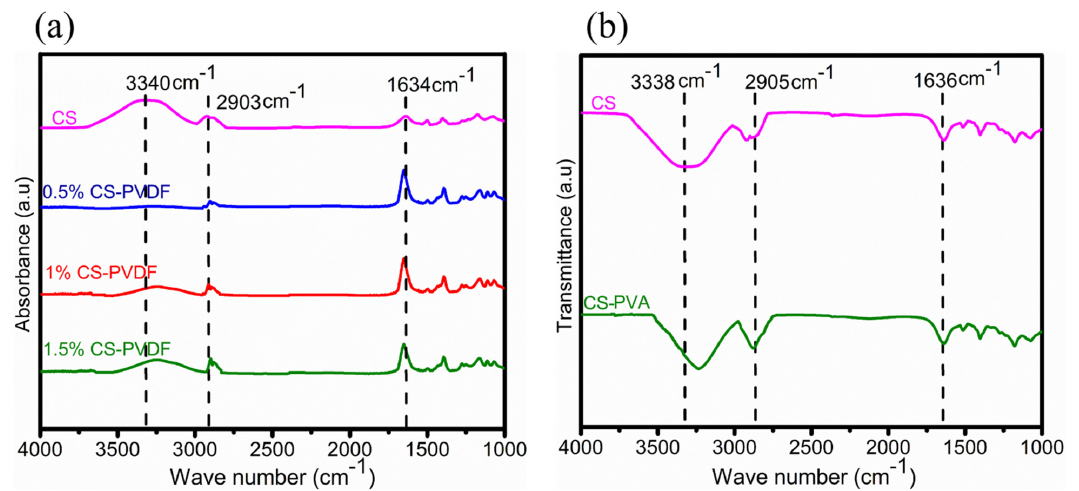
Figure 4. FTIR spectra for pure CS, CS ‐ PVDF, and CS ‐ PVA composite materials: ( a ) different concentrations of CS in PVDF dope while maintaining LiCl concentration constant at 1%; ( b ) FTIR spectra of CS and CS ‐ PVA.